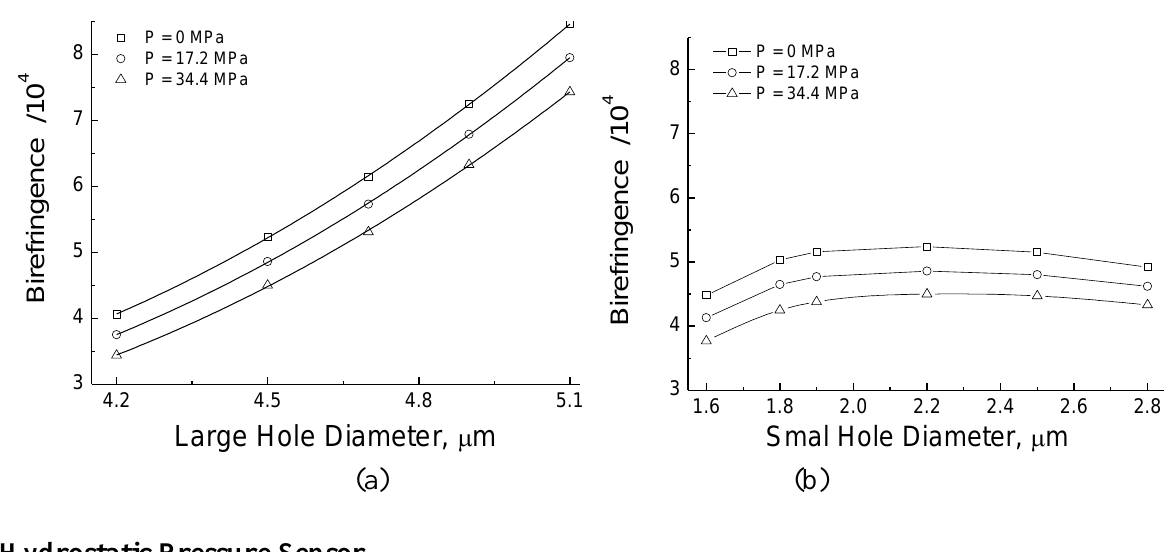
Figure 3. Phase modal birefringence variation with (a) the diameter of the large holes when d = 2.2 µm and (b) the diameter of he small holes when D = 4.5 µm. Lines are for eye guidance. In all cases, λ = 1,550